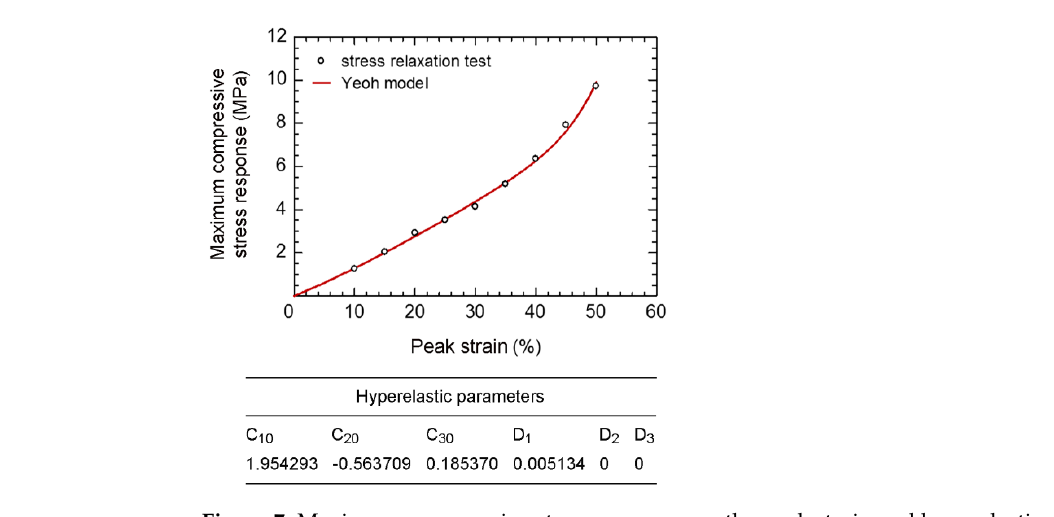
Figure 8. Compressive stress response vs. time of disc-A during viscoelastic period of stress relaxa- tion test.